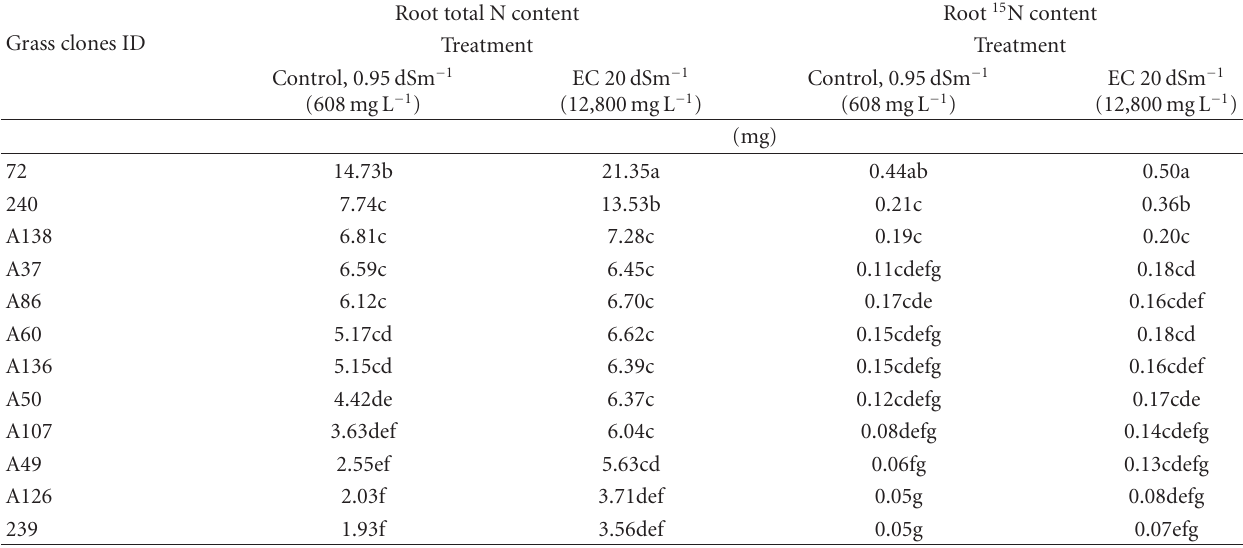
Table 7: Total nitrogen and 15 N contents (mg) of various clones of saltgrass root tissues under the control and salt (NaCl) stress